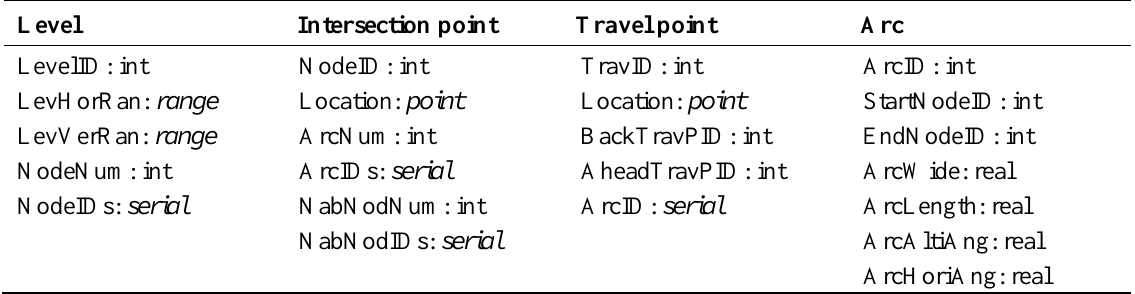
Table 1. The level, the intersection point, the travel point and the arc data structure.